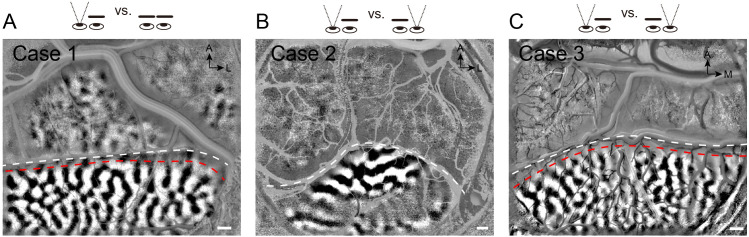
Very little V2 is available on surface.Location of V1/V2 border revealed by ocular dominance mapping (three cases). White dashed line: lunate sulcus. Red dashed line: V1/V2 border.